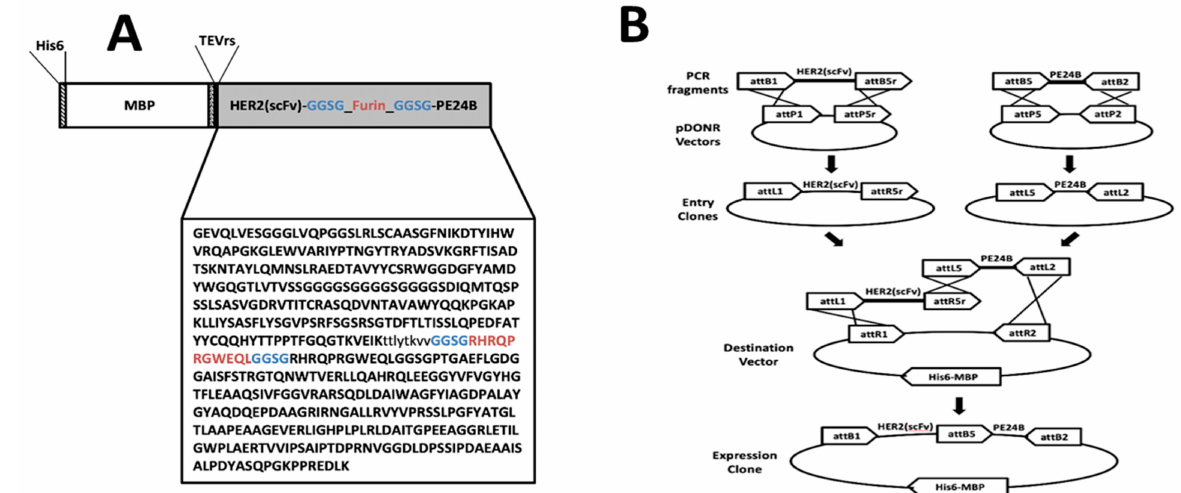
Figure 1. Design and construction of the HER2(scFv)-PE24B immunotoxin fusion protein. ( A ) Schematic representa- tion of MBP-HER2(scFv)-PE24B. ( B ) The MBP-HER2(scFv)-PE24B plasmid was constructed by the multisite Gateway cloning method.